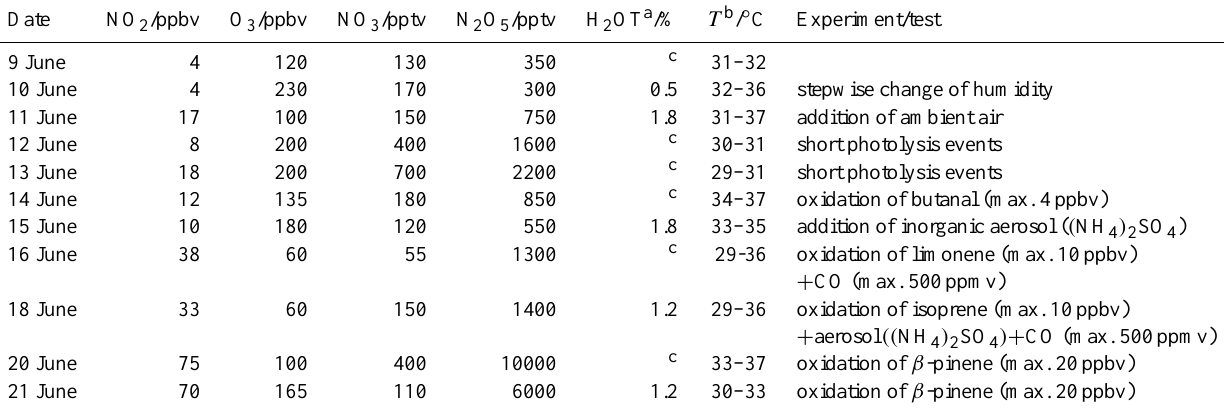
Table 2. Chemical conditions during experiments conducted during the NO3Comp campaign. Mixing ratios are maximum values during the